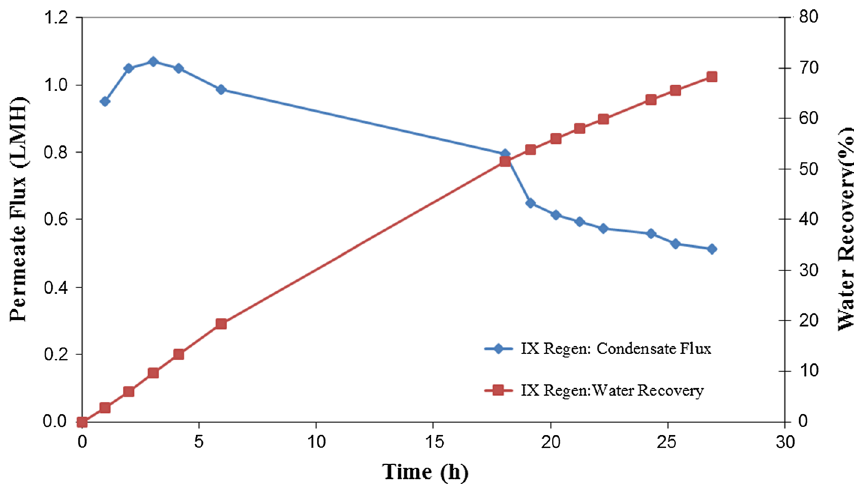
Fig. 5 Condensate (permeate) flux and water recovery as a T function of time ( f = 34 °C; q T f = 80 l/h; p = 11 °C; q